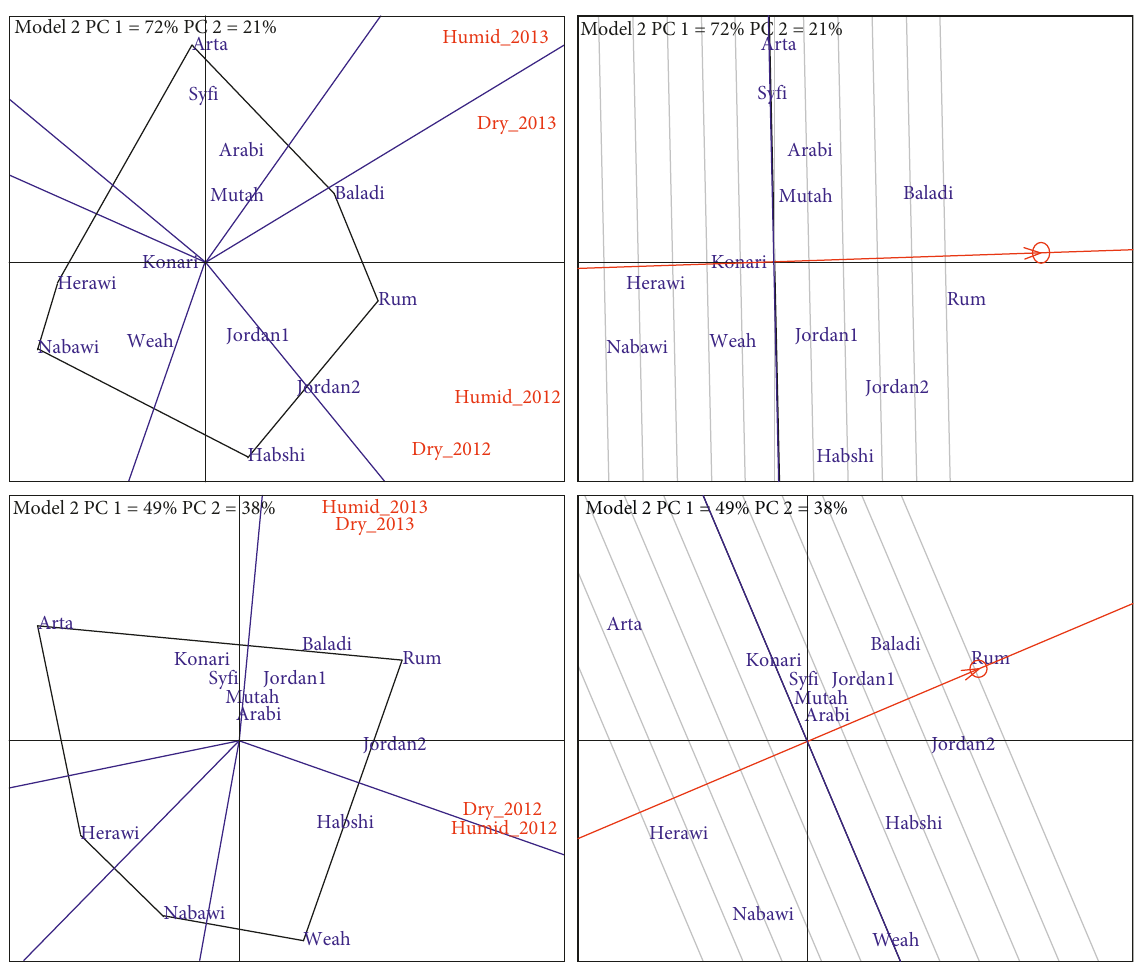
Figure 3: GGE biplot analysis for GW (a) and TW (b) and stability analysis using biplot for GW (c) and TW (d) of 13 barley genotypes grown across four different environments.